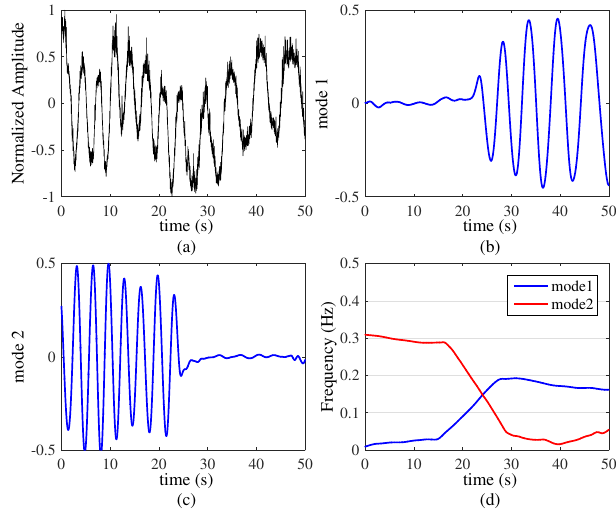
Figure 6. Two targets with piecewise-constant respiration rates ( k = 3, α = 20,000). ( a ) Original signals; ( b ) and ( c ) two modes decompose by VMD based algorithm; ( d ) time-varying respiration